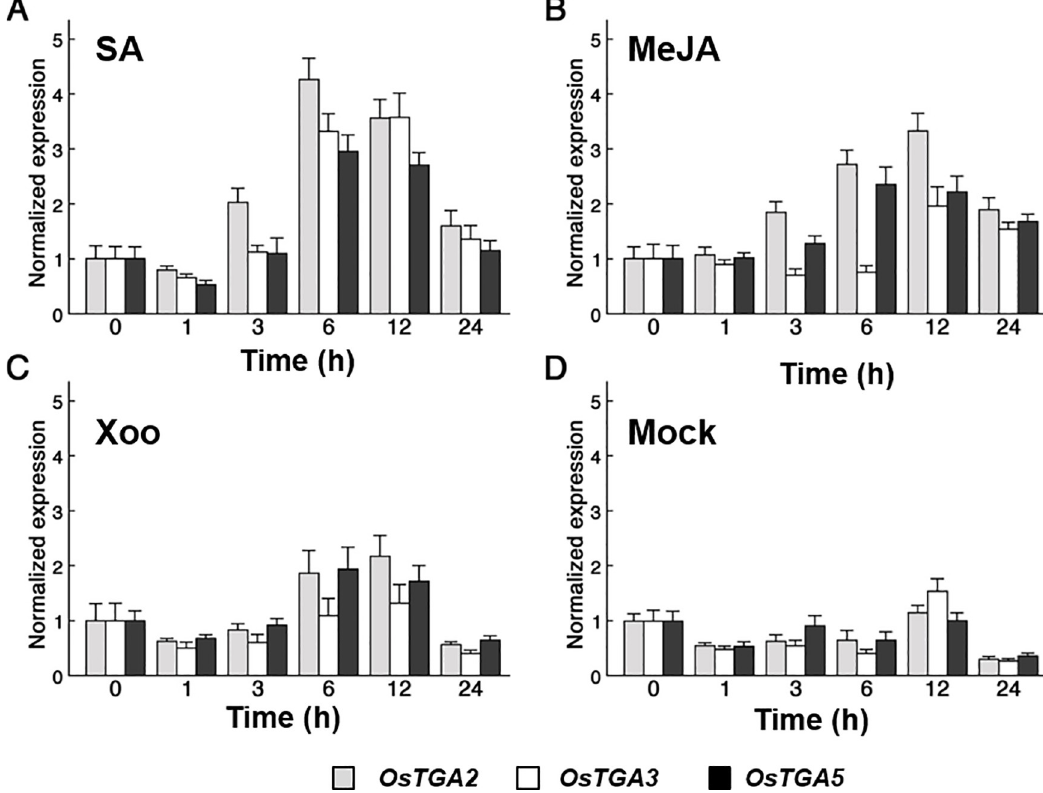
Fig 1. Expression of OsTGA transcription factors in rice. (A and B) Expression profiles of OsTGA genes in rice seedlings in response to treatments of exogenous SA at 2 mM (A) and MeJA at 100 μ M (B) (C and D) Expression profiles of OsTGAs upon Xoo challenge. Leaves inoculated with Xanthomonas oryzae pv. oryzae ( Xoo ) KACC10331 (C) or inoculated with sterile water (D) were collected. Total RNA extracted from these samples was used for cDNA synthesis followed by qRT-PCR analysis. Bars represent mean ± standard deviation. Data are obtained from three independent replicated experiments. Gray, white, and black boxes indicate Os TGA2 , Os TGA3 , and Os TGA5 , respectively.